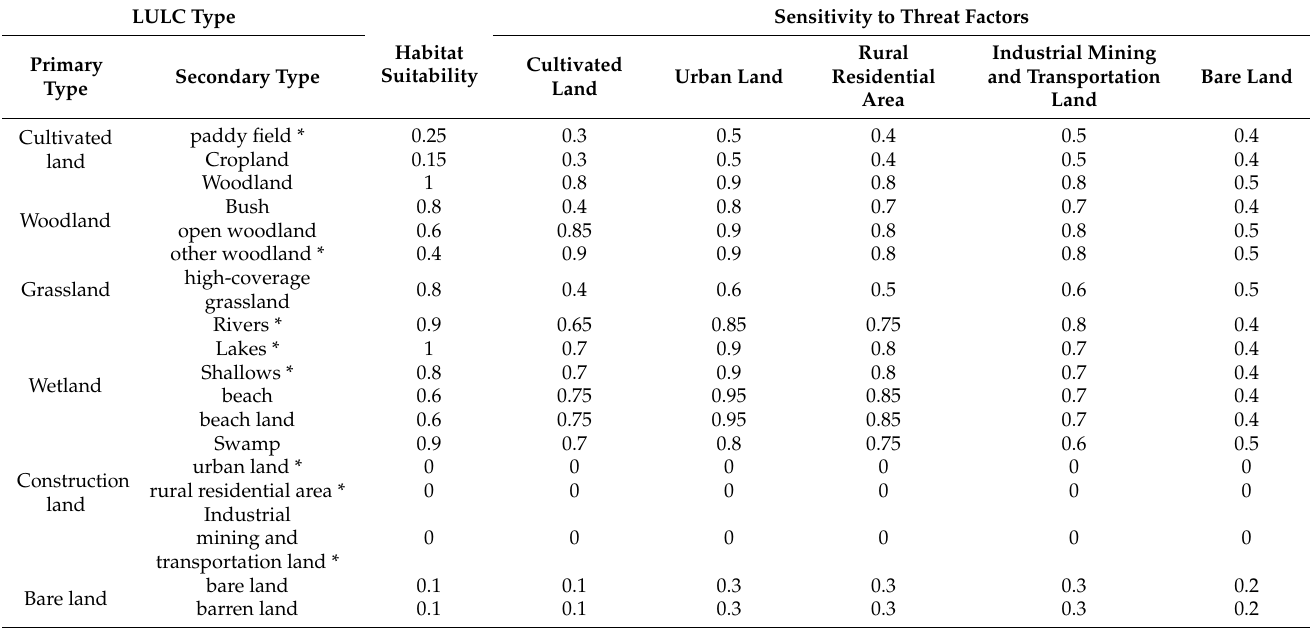
Table 2. Habitat suitability of different landscape types and sensitivity of LULC types to each